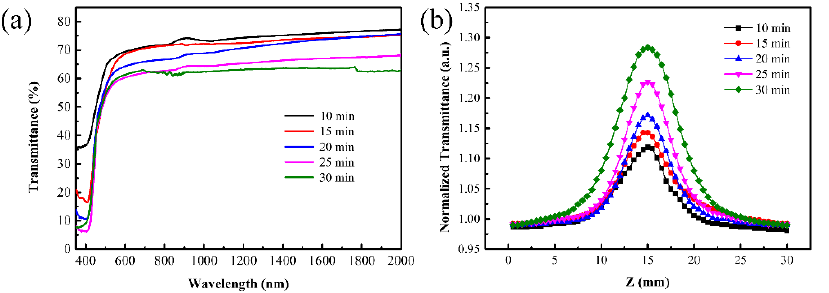
Figure 4. Transmittance spectra ( a ) and the open-aperture Z-scan curves ( b ) of the V 2 O 5 film with different thicknesses.